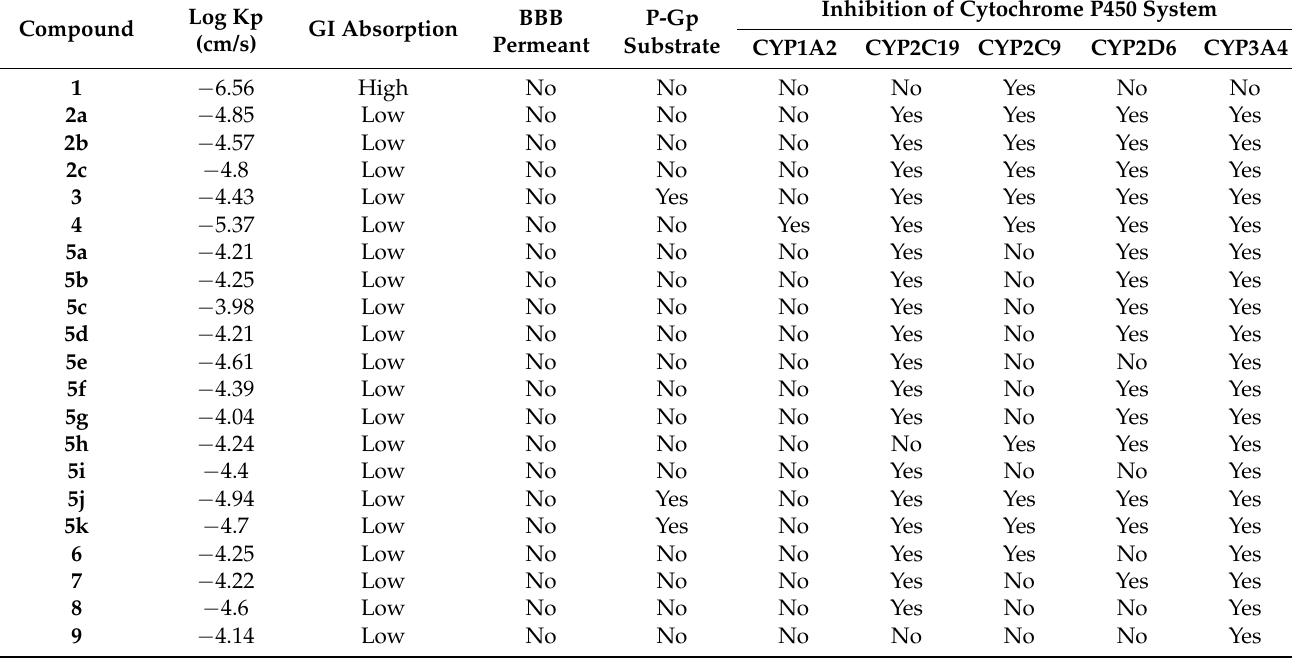
Table 2. Pharmacokinetic and drug excretion properties of thiazole derivatives bearing β -amino acid and aromatic